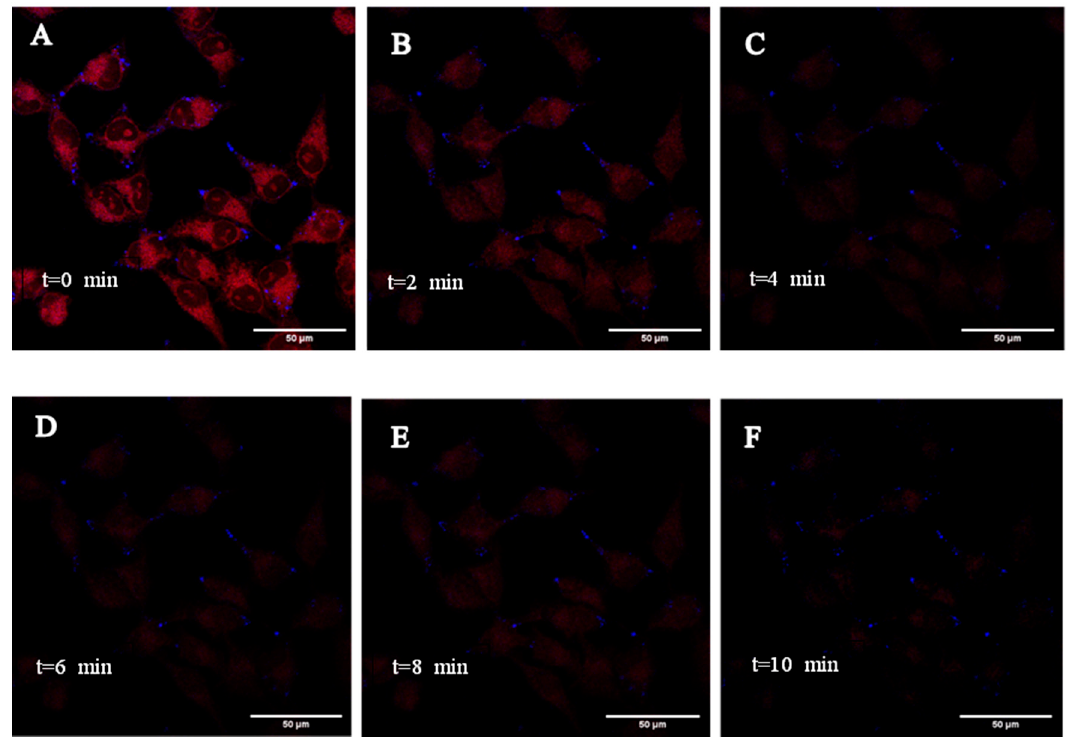
Figure 8. Time lapse live cell imaging of HeLa cells stained with B6,5 (1 µM) and co-stained with Hoechst 33,342 and treated with 1 molar equivalent of quarfloxin. The images were captured at fixed z-value over a period of 10 min at every 2-min interval ( A – F ). For clarity, images are presented in pseudo colors of red for B6,5 and blue for Hoechst 33342.